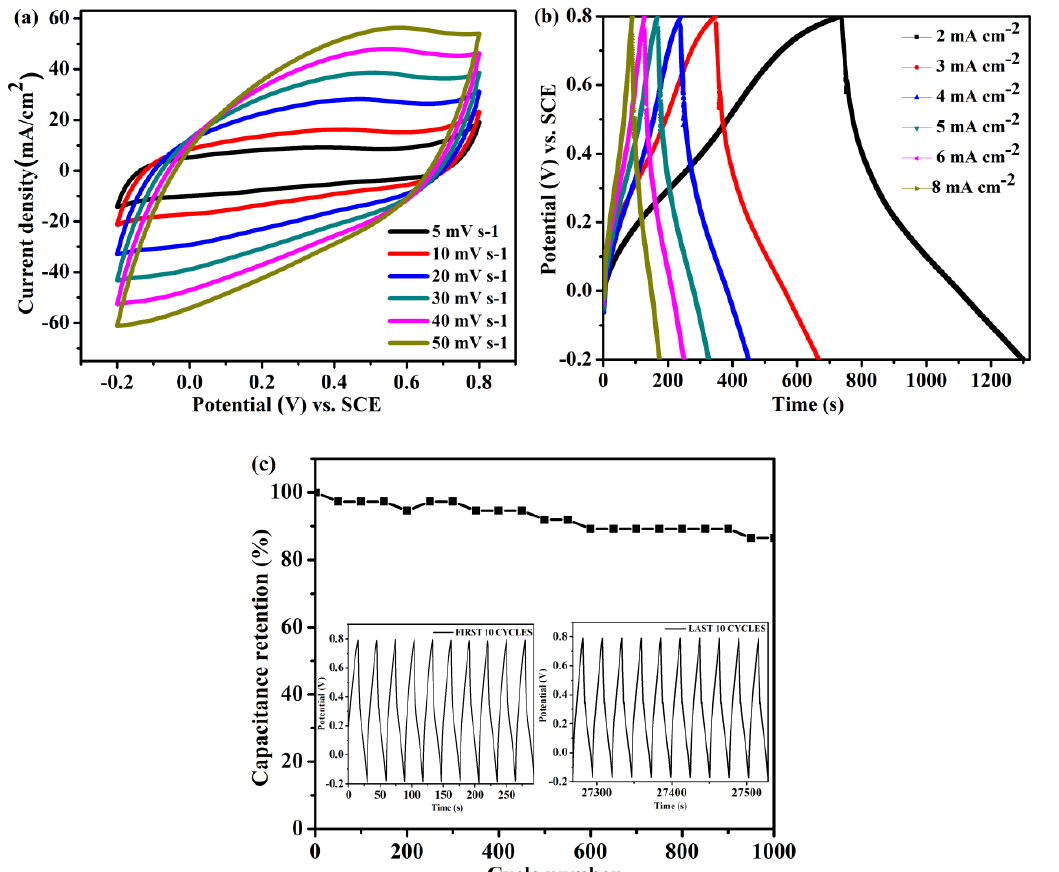
Figure 6. ( a ) CV curves recorded at various scan rates, ( b ) GCD curves recorded at various current densities, and ( c ) cycling life stability after 1000 cycles for the KF@PPy/ f -CNT11 freestanding hybrid electrode. Inset: First and last 10 cycles.